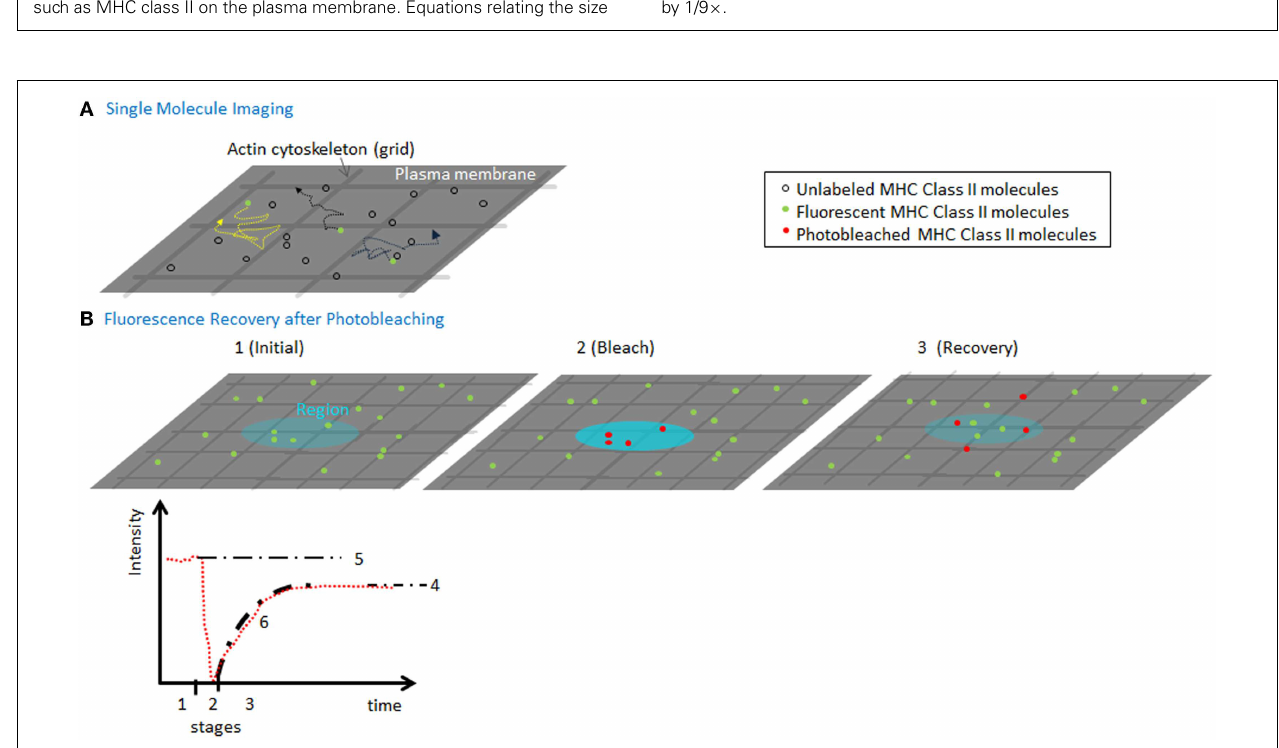
FIGURE 1 | Mobility of MHC molecules in the membrane . Diagram illustrating lateral diffusion and rotational diffusion of membrane proteins such as MHC class II on the plasma membrane. Equations relating the size